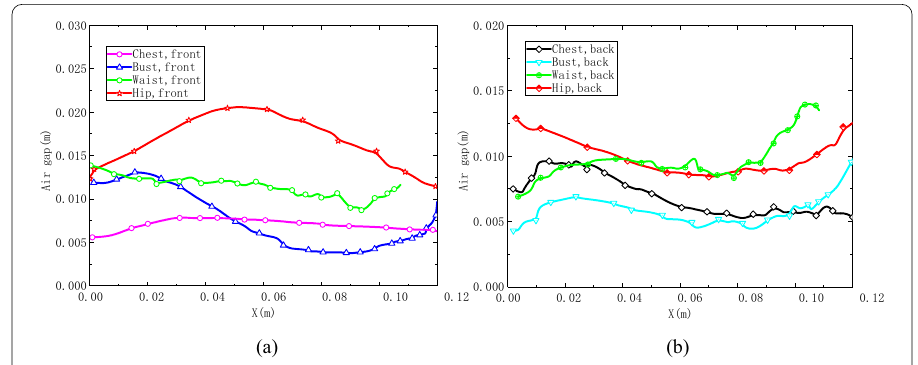
Fig. 4 Air gap distance distributions. a Air gap distance of front side, b air gap distance of back